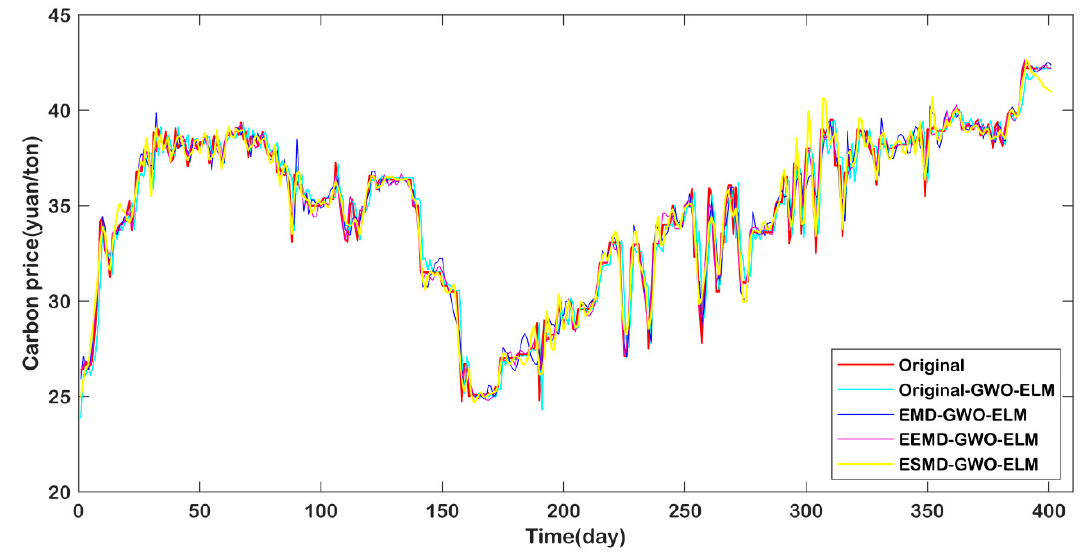
Figure 17. The results of Shanghai carbon price forecasting.